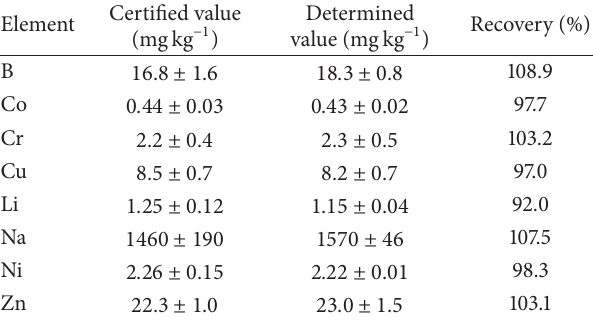
Table 4: Determined and certified values of elements in GBW10028 ( Astragalus membranaceus ), 𝑛 = 4